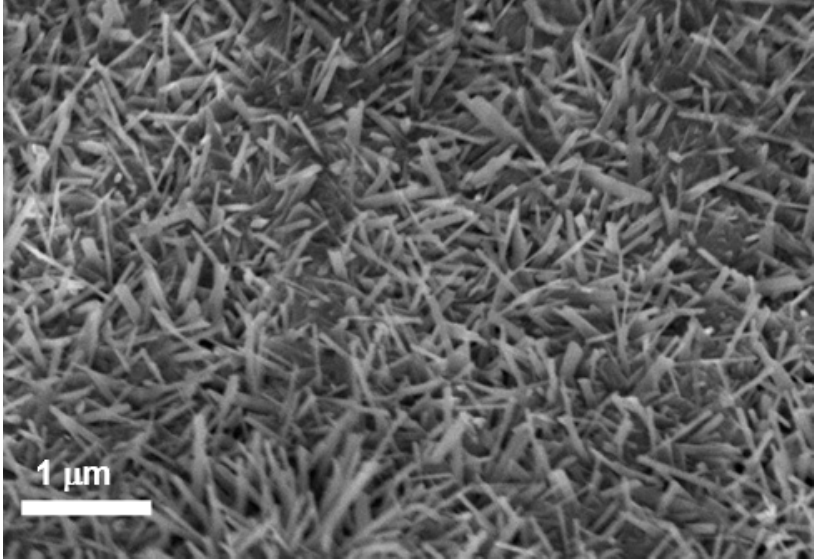
Figure 1. Surface morphology of pristine TNWs before GO/rGO nanosheet deposition.